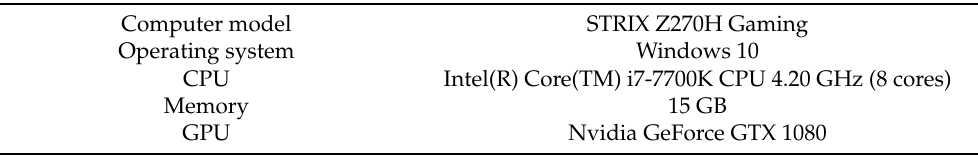
Table 2. The applied computer configuration of the